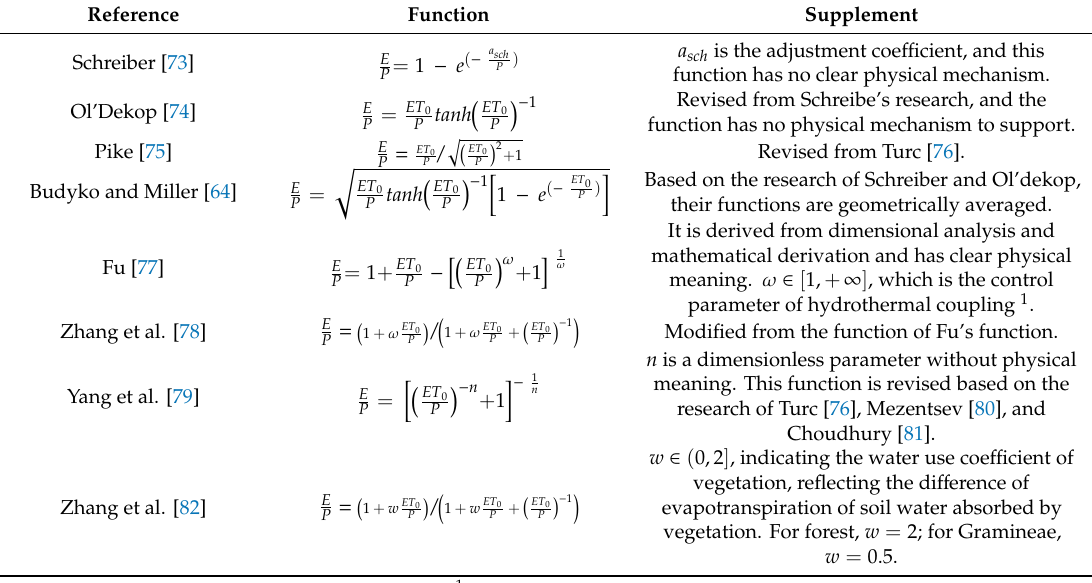
Table 2. Relationship between the aridity index and evapotranspiration index based on the Budyko